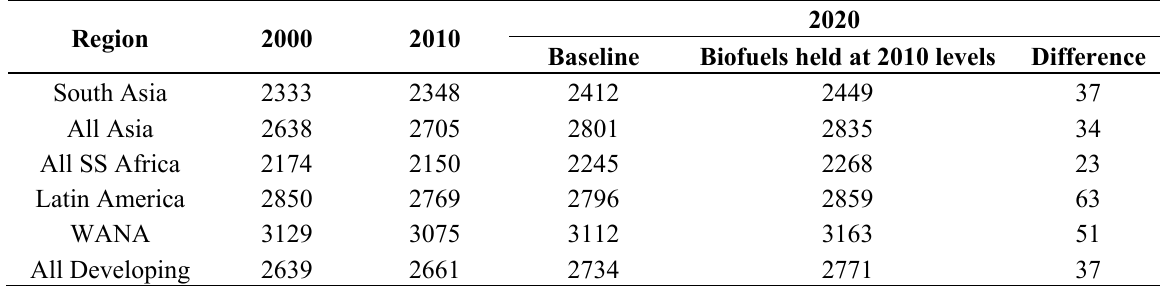
Table 1. Per capita calorie availability from food under baseline and scenario (kilo calories per person per day).